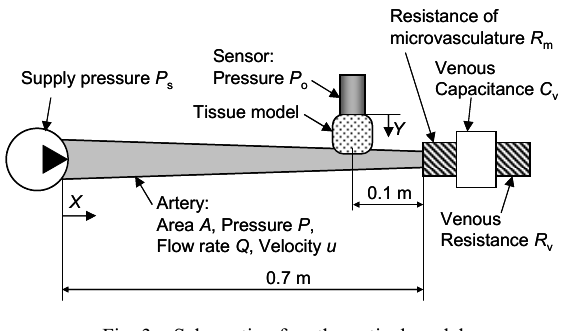
Fig. 3 Schematic of mathematical